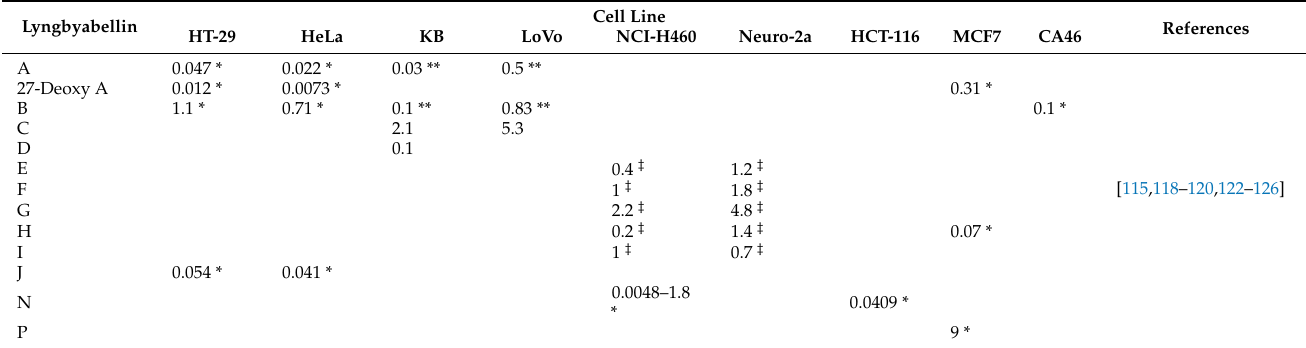
Table 9. Lyngbyabellin analog activities on cancer cell lines.